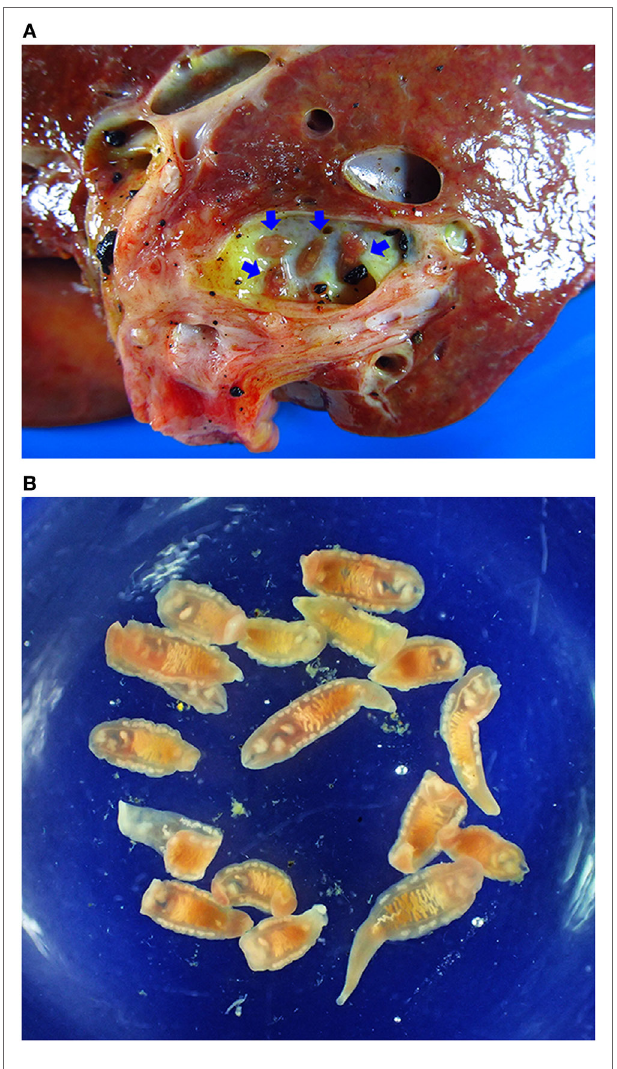
FigURe 2 | Opisthorchiasis-associated cholangiocarcinoma. (A) Cholangiocarcinoma specimen showing adult worms in the bile duct (blue arrows). (B) Adult Opisthorchis viverrini recovered from the